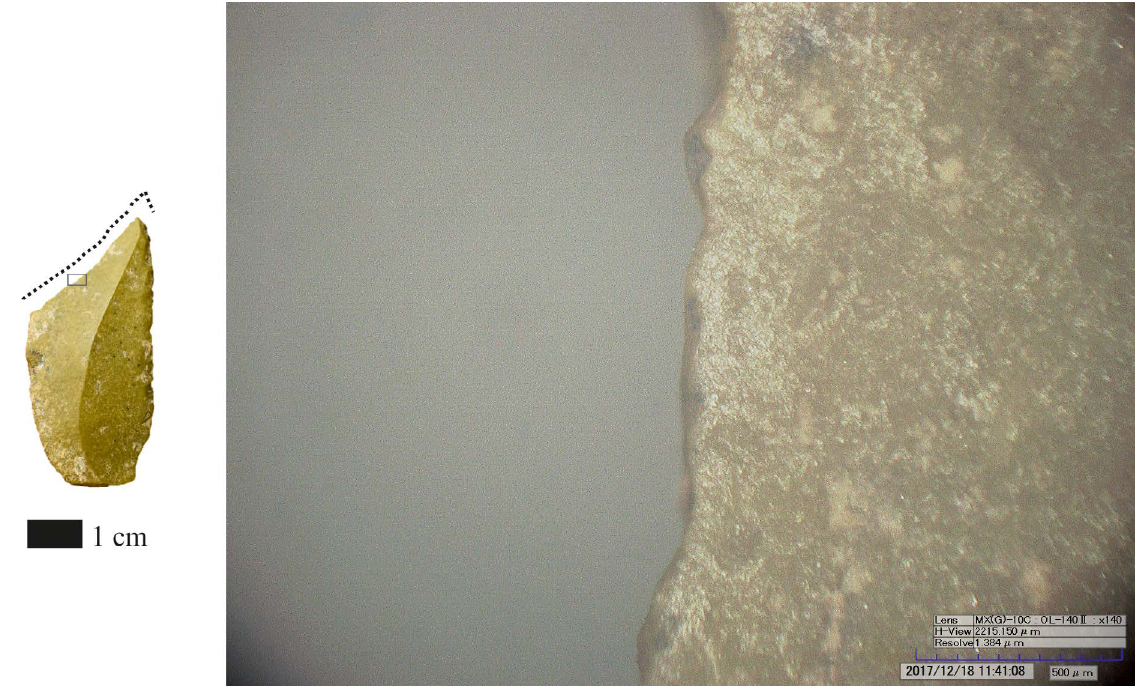
Figure 15. Use-wear polish on the big blade ID 1384 (the scale bar is 500